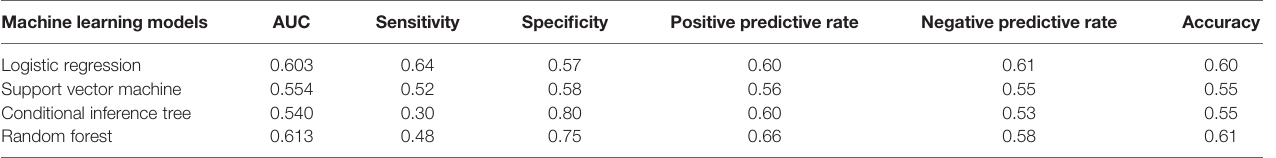
TABLE 2 | Performance comparison among the four machine learning algorithms in predicting clinical pregnancy. Machine learning models